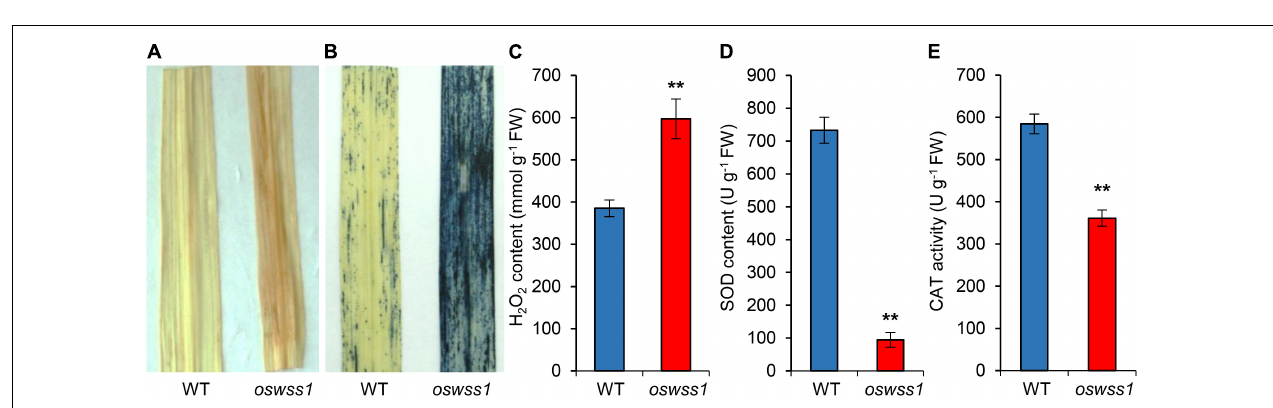
FIGURE 7 | Mutation of OsWSS1 causes early leaf senescence and premature cell death. (A) Leaf morphology between wild type (WT) and oswss1 plants at the heading stage (118 DAS). Scale bar = 4 cm. (B) Transcriptional level analysis of senescence-related genes between WT and oswss1 plants at the tillering stage (87 DAS) by qRT-PCR. OsActin was used as an internal control. The gene expression of WT was normalized to 1 after the normalization with the value of OsActin . Values are mean ± SD ( n = 3). ** P < 0.01 (Student’s t -test). (C) Comparison of the malondialdehyde (MDA) contents between WT and oswss1 leaves at the tillering stage. Values are mean ± SD ( n = 6). ** P < 0.01 (Student’s t -test). (D) The trypan blue staining of leaves between WT and oswss1 plants at the tillering stage. (E) TUNEL assay of WT and oswss1 leaves at the tillering stage. Blue signal is 4 (cid:48) ,6-diamino-phenylindole (DAPI) staining, green fluorescence represents TUNEL-positive signals. Scale bars = 50 µ m.